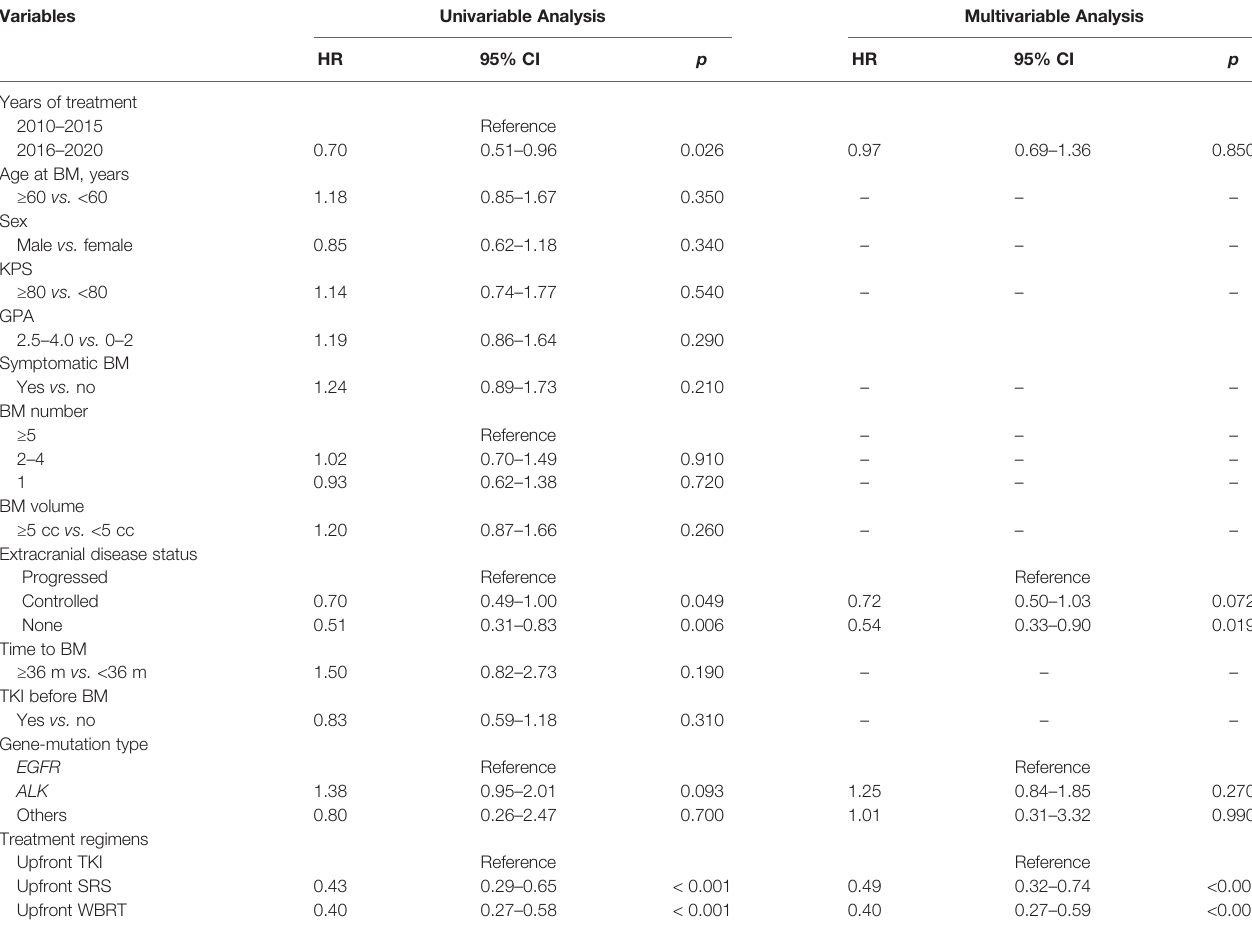
TABLE 4 | Univariable and multivariable analyses of prognostic variables for iPFS in the entire group (competing risks regression analysis). Variables